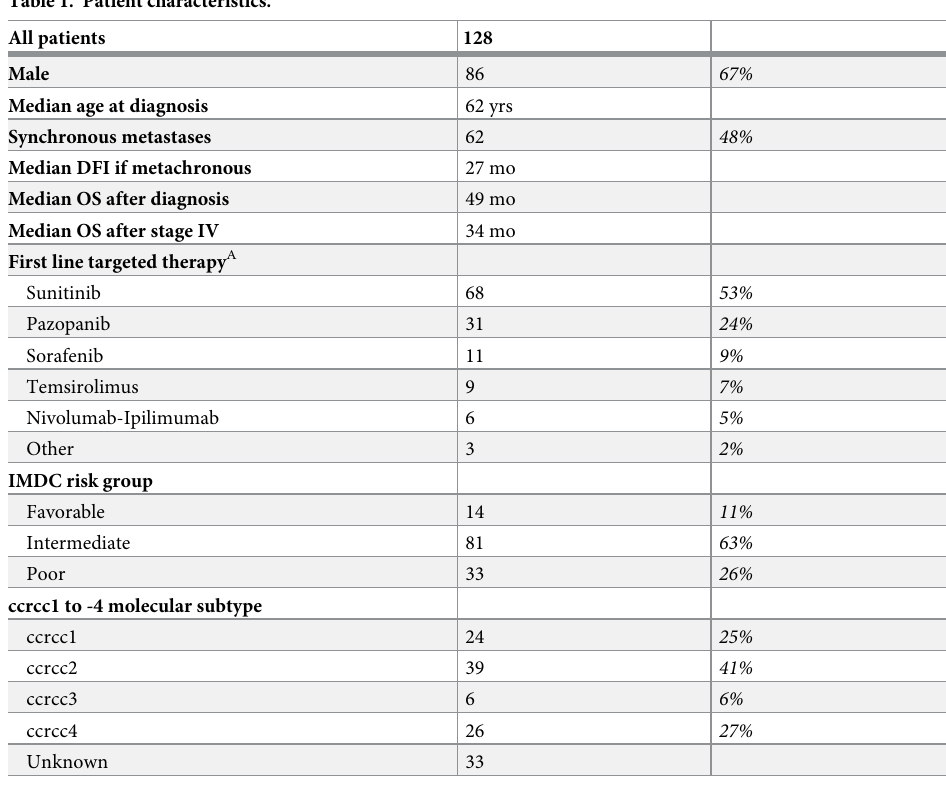
A All patients were treated for metastatic disease. No patients received adjuvant